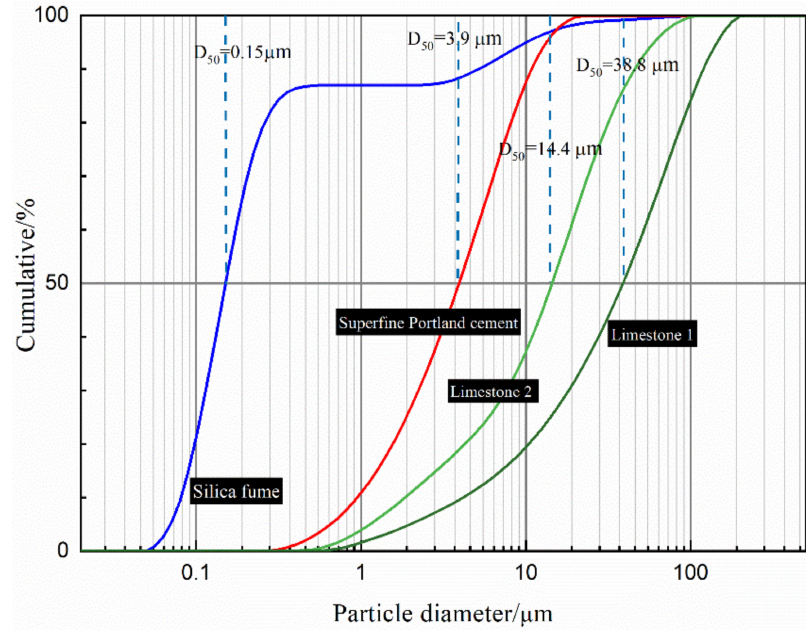
Figure 2. Particle size distribution curve of raw